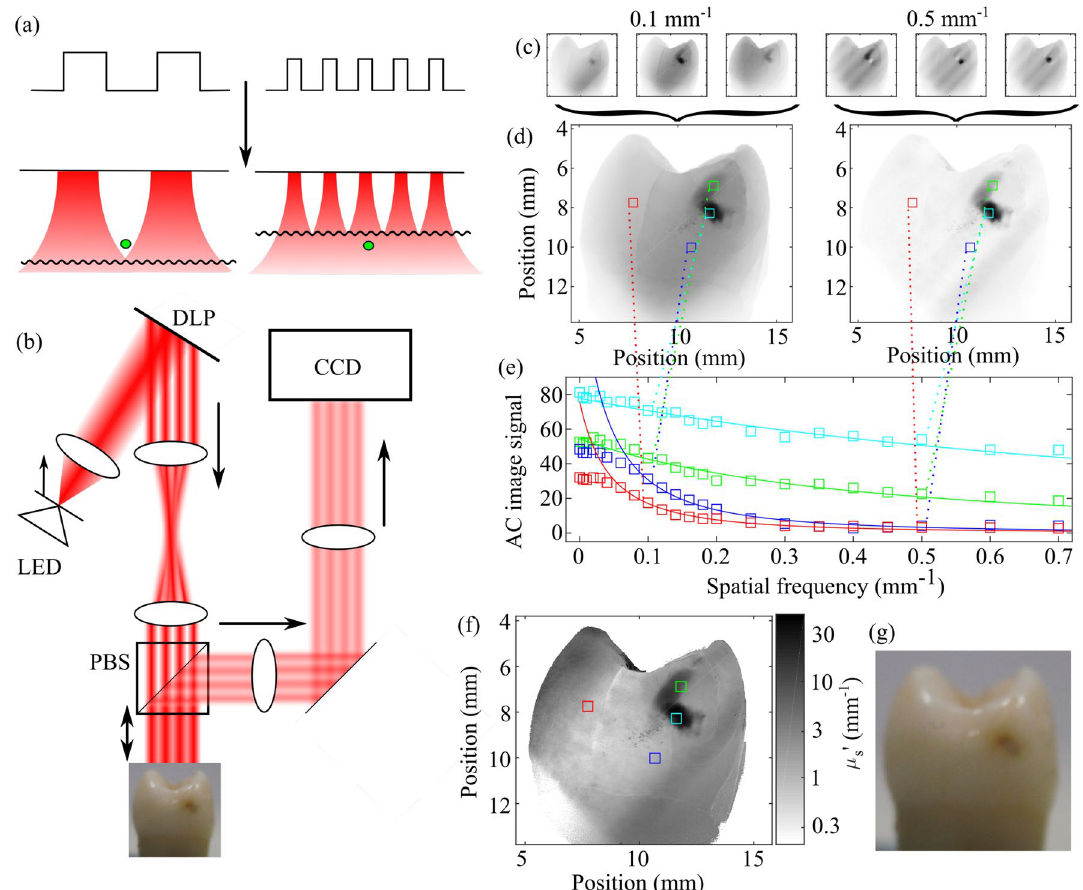
Figure 1. Principles, implementation and analysis techniques in spatial frequency domain imaging. Patterns of light are blurred and attenuated passing through tissue, shown in ( a ). The depth to which the pattern penetrates before being blurred to the point of uniform illumination is illustrated by the curved line. The imaging of a defect (green circle) is phase-dependent at low spatial frequencies (left) but phase-independent at high spatial frequencies (right). ( b ) A collimated LED is encoded with an intensity pattern using a digital light projector (DLP). This pattern of light is transmitted through a telescope and a polarizing beam splitter (PBS) to illuminate an extracted tooth. Specular reflections are transmitted through the PBS, whilst back-scattered light is reflected through an imaging system to a CCD camera. From these images ( c ), the AC image (i.e. the phase-dependent component of the image) can be calculated ( d ). The AC image signal dependence on pattern spatial frequency ( e ) yields the reduced scattering coefficient ( f ), which provides insight not available when using purely visible imaging ( g